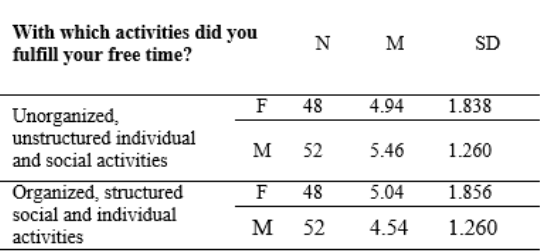
Table 6. Representation of the principle of free choice among the young people when choosing free ac-